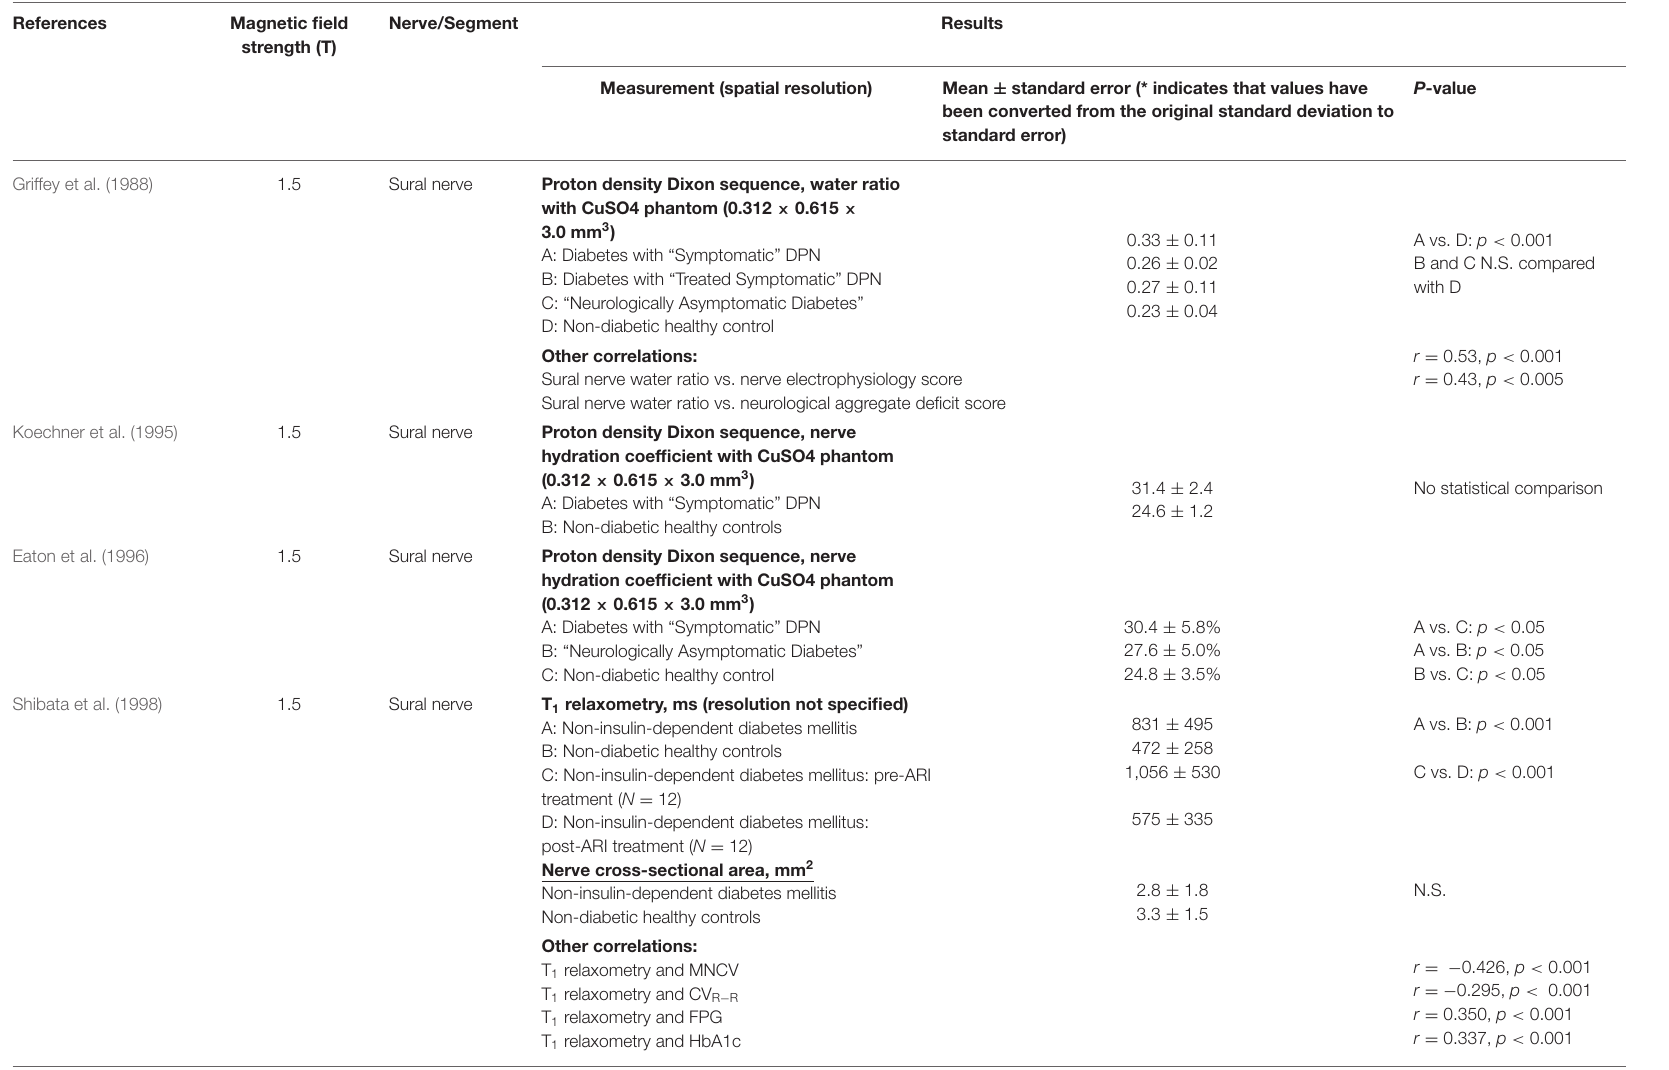
TABLE 2 | Results